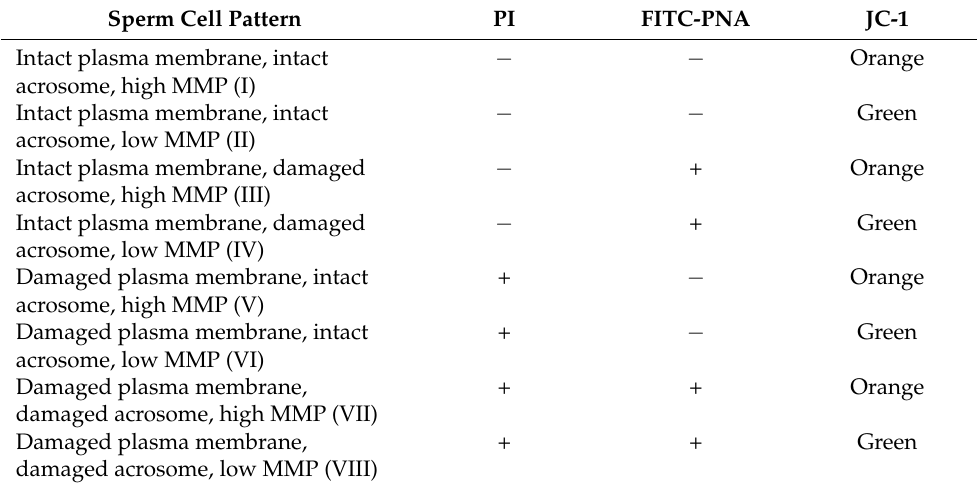
Table 1. Sperm classification by simultaneous assessment of plasma membrane integrity (propidium iodide—PI), acrosome integrity (fluorescein isothiocyanate peanut (Arachis hypogaea) agglutinin— FITC/PNA) and mitochondrial membrane potential (JC-1) by triple stain fluorescent probes. Sperm Cell Pattern PI FITC-PNA JC-1 − − Orange Intact plasma membrane, intact acrosome, high MMP (I) − − Green Intact plasma membrane, intact acrosome, low MMP (II) − + Orange Intact plasma membrane, damaged acrosome, high MMP (III) Intact plasma membrane, damaged Green acrosome, low MMP (IV) Damaged plasma membrane, intact acrosome, high MMP (V) Damaged plasma membrane, intact acrosome, low MMP (VI) Damaged plasma membrane, damaged acrosome, high MMP (VII) Damaged plasma membrane, damaged acrosome, low MMP